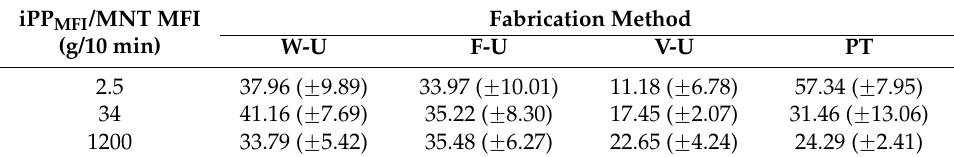
iPP MFI /MNT MFI (g/10 min)